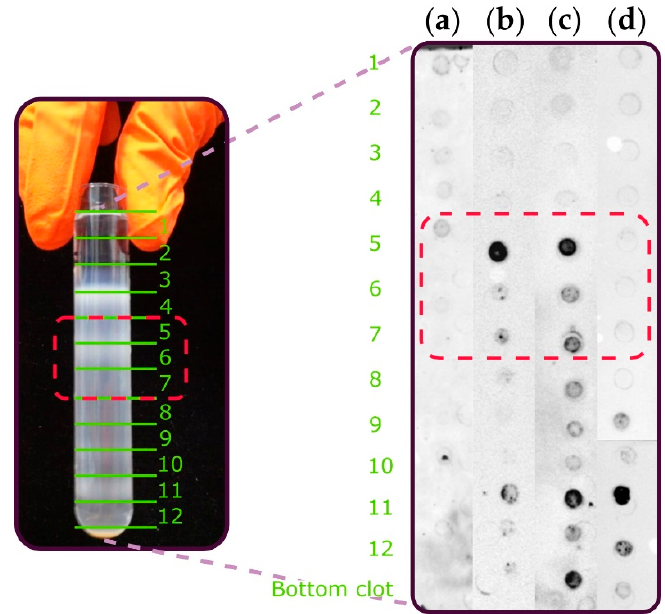
Figure 1. Specific protein markers assessed by immunoblot. ( a ) The neutrophil cytosolic factor 1 (NCF1) marker of cytosol was present in the first four fractions. ( b ) The Flotillin-1 marker of cholesterol-rich microdomains was mainly detected in fractions 5–7 of sucrose. ( c ) The glycoprotein Ib (GPIb) marker of platelet plasma membrane was present in fractions 5–12 and ( d ) the cytochrome c oxidase IV (COX IV) marker of mitochondria was mainly present in fractions 9–12.